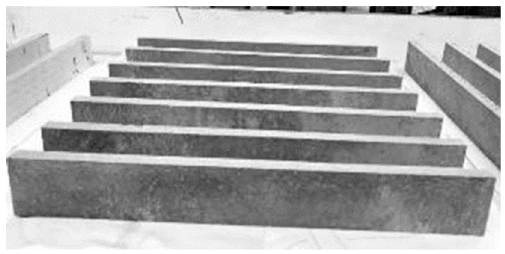
Figure 5. TRC samples after cutting.